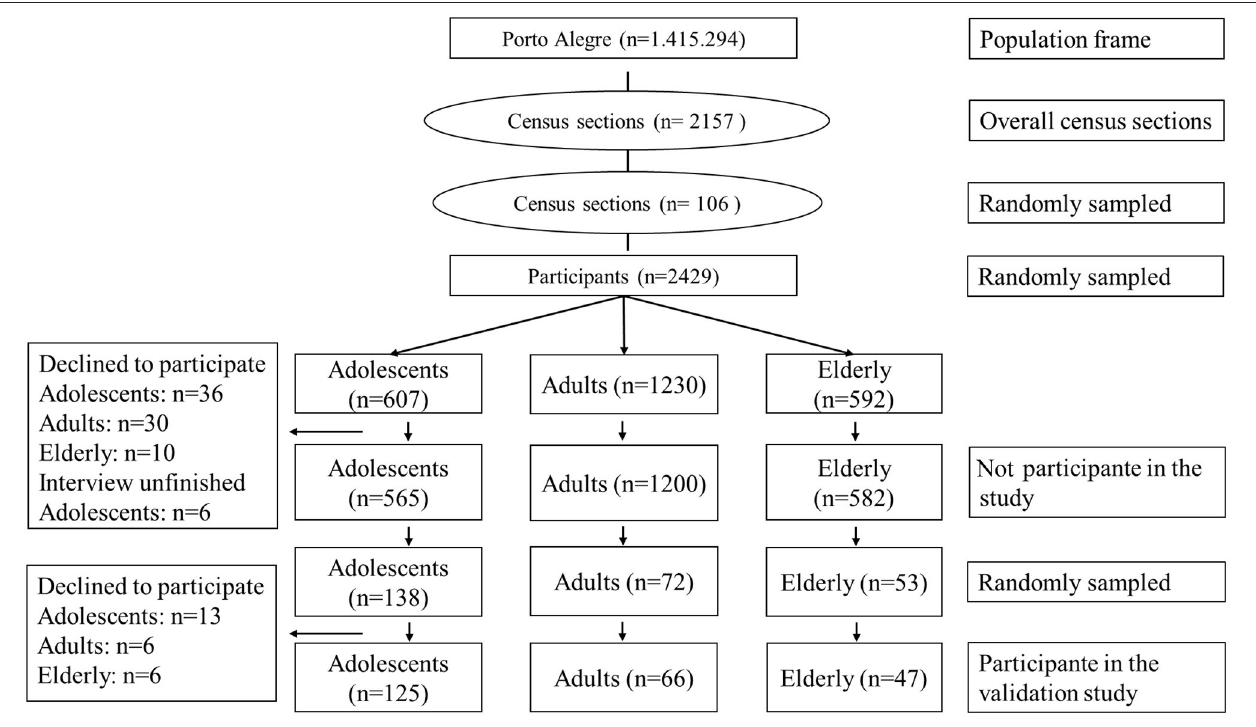
FIGURE 1 | Flowchart describing the selection of